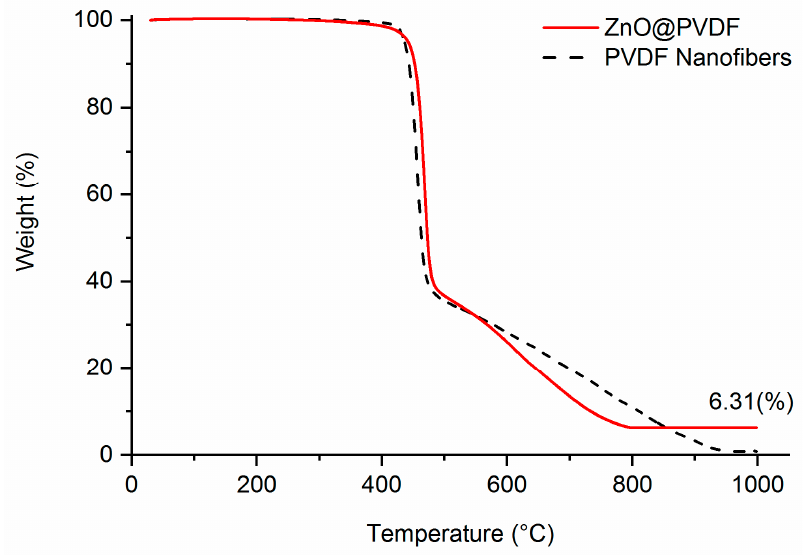
Figure 4. TGA of PVDF membrane, and ZnO@PVDF.